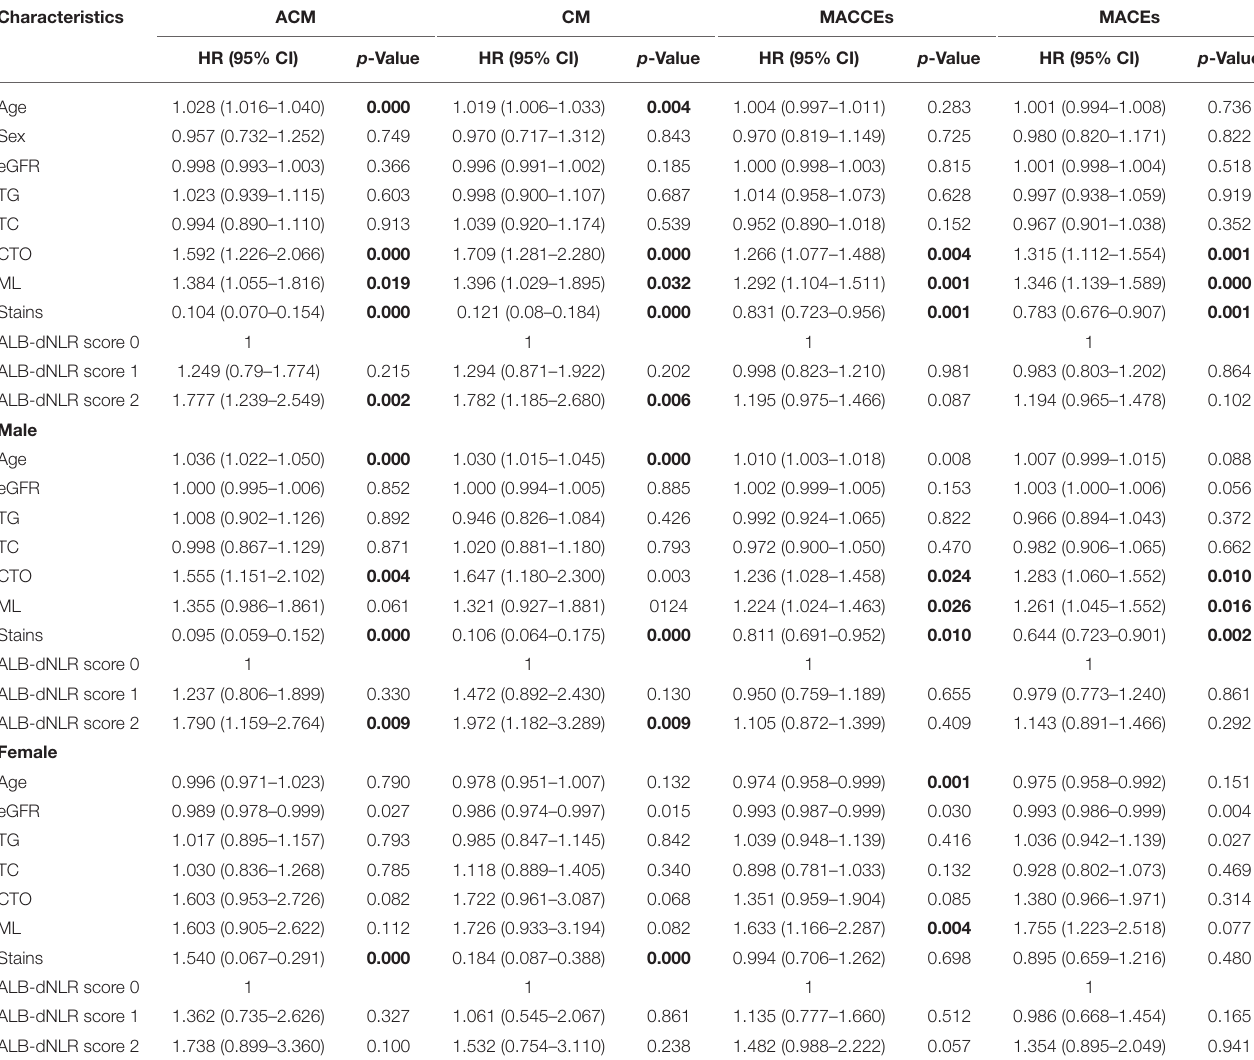
TABLE 5 | Cox proportional hazards analysis of ACM, cardiac death, MACCEs, and MACEs.